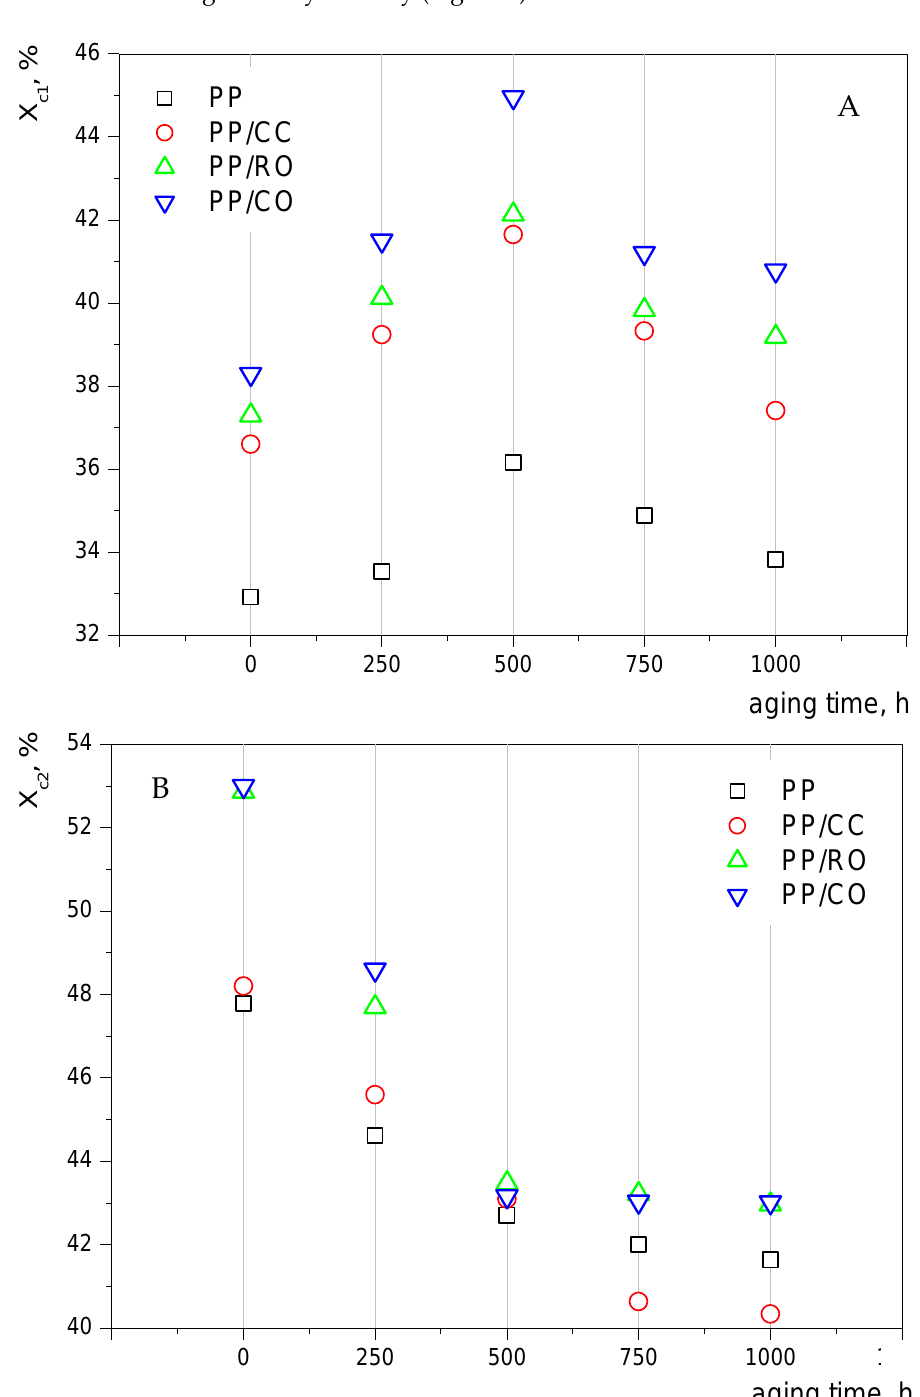
Figure 1. Degree of crystallinity of iPP and its composites, determined by DSC: ( A ) — first heating; ( B ) — second heating. Table 2. Thermal properties of the iPP composites (first and second heating cycles) as a function of accelerated aging.